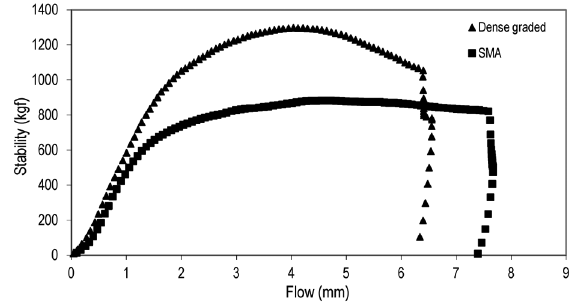
Fig. 4. The stability-flow curves of SMA and dense graded asphalt (Kok et al. 2014)